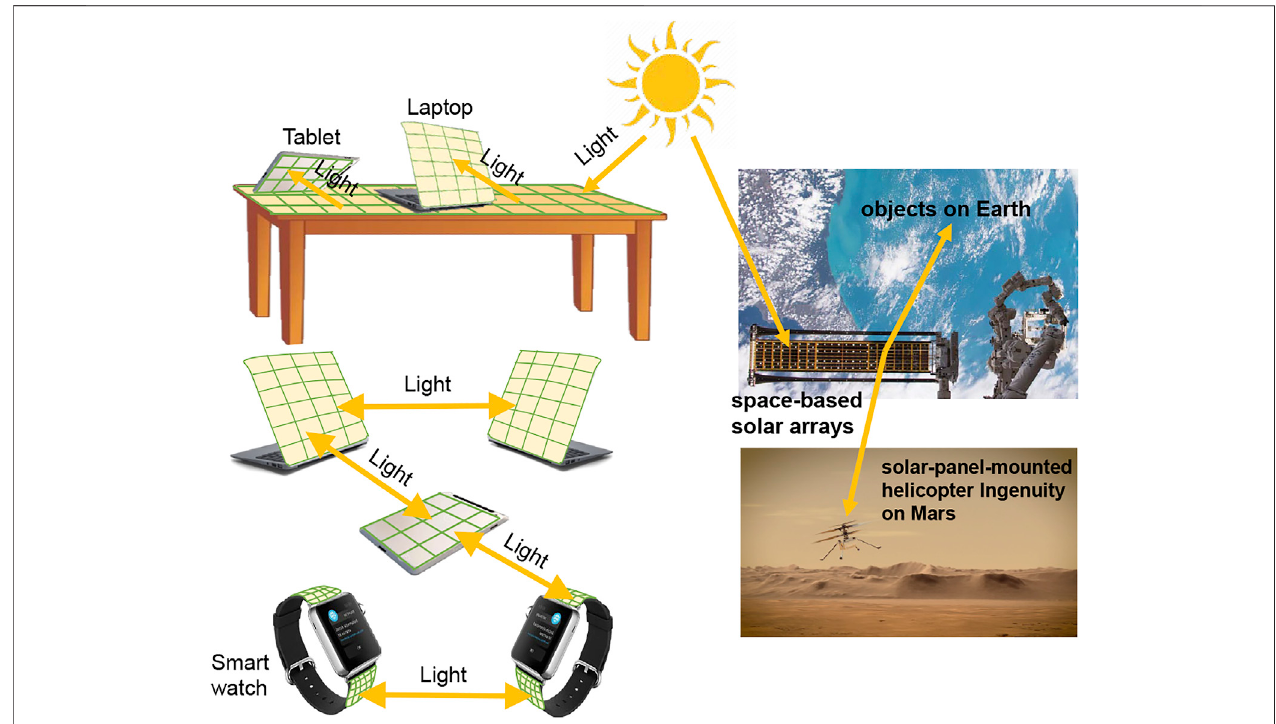
FIGURE 1 | Envisioned illustration of the proposed conceptual OWPT system toward realization of a T2T-OWPT network (e.g., table – laptop, table – tablet, laptop – laptop, tablet – watch, and watch – watch bidirectional OWPT).